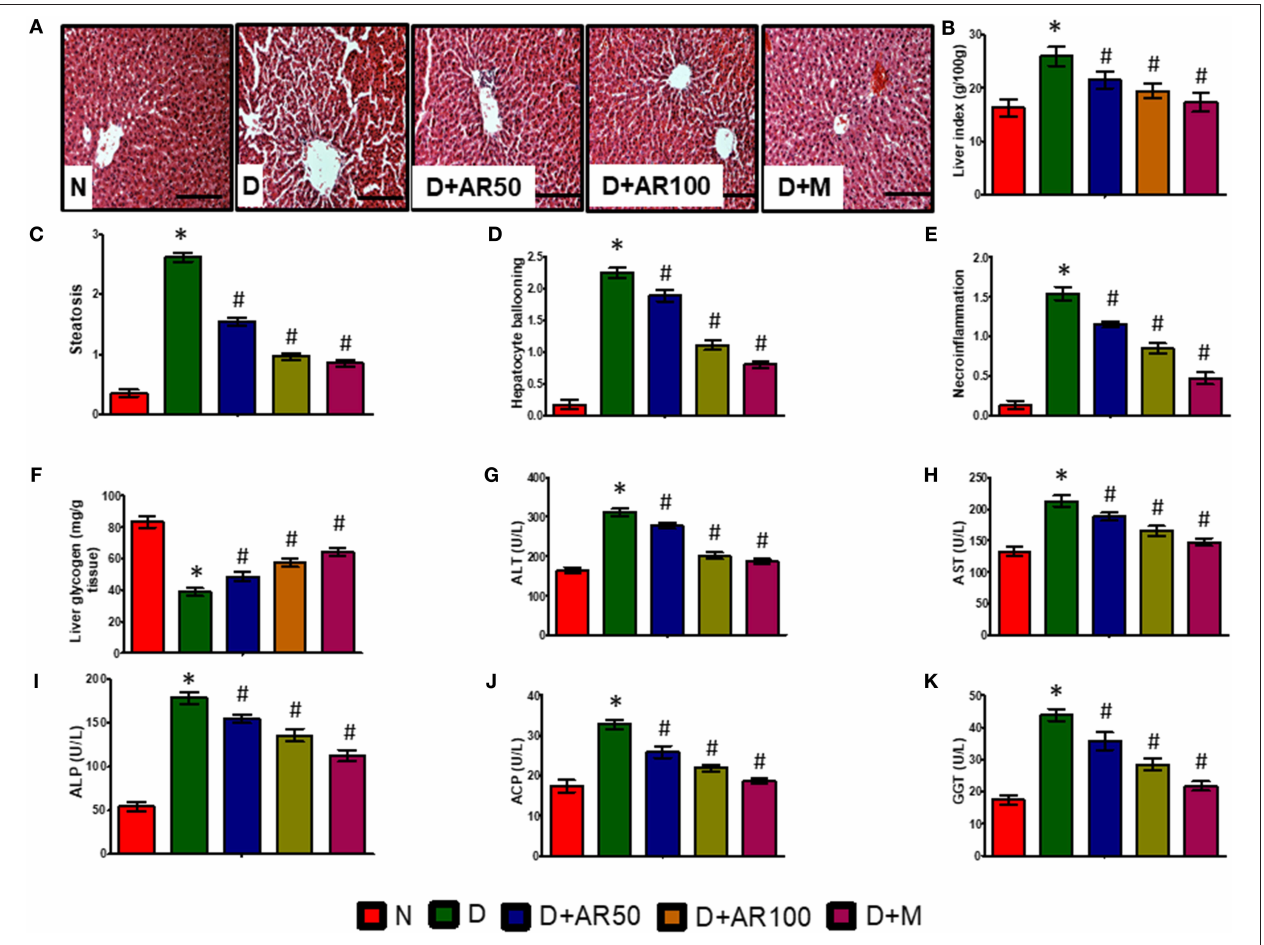
FIGURE 5 | Effect of Annona reticulata L on (A) Histology of liver (B) Liver tissue somatic index (C) Steatosis (D) Hepatocyte ballooning (E) Necroinflammation (F) Liver glycogen (G) Alanine aminotransferase (ALT) (H) Aspartate aminotransferase (AST) (I) Alkaline phosphatase (ALP) (J) Acid phosphatase (ACP) (K) Gamma-glutamyl transferase (GGT). Each value is mean ± SD of six rats in each group. *significant compared to normal control group p < 0.01. # significant compared to diabetic group p <